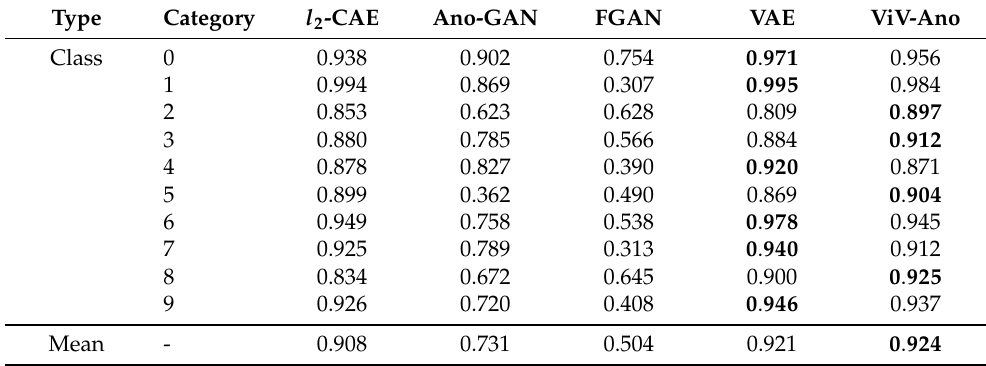
Table 1. Performance comparison of anomaly detection methods in MNIST.